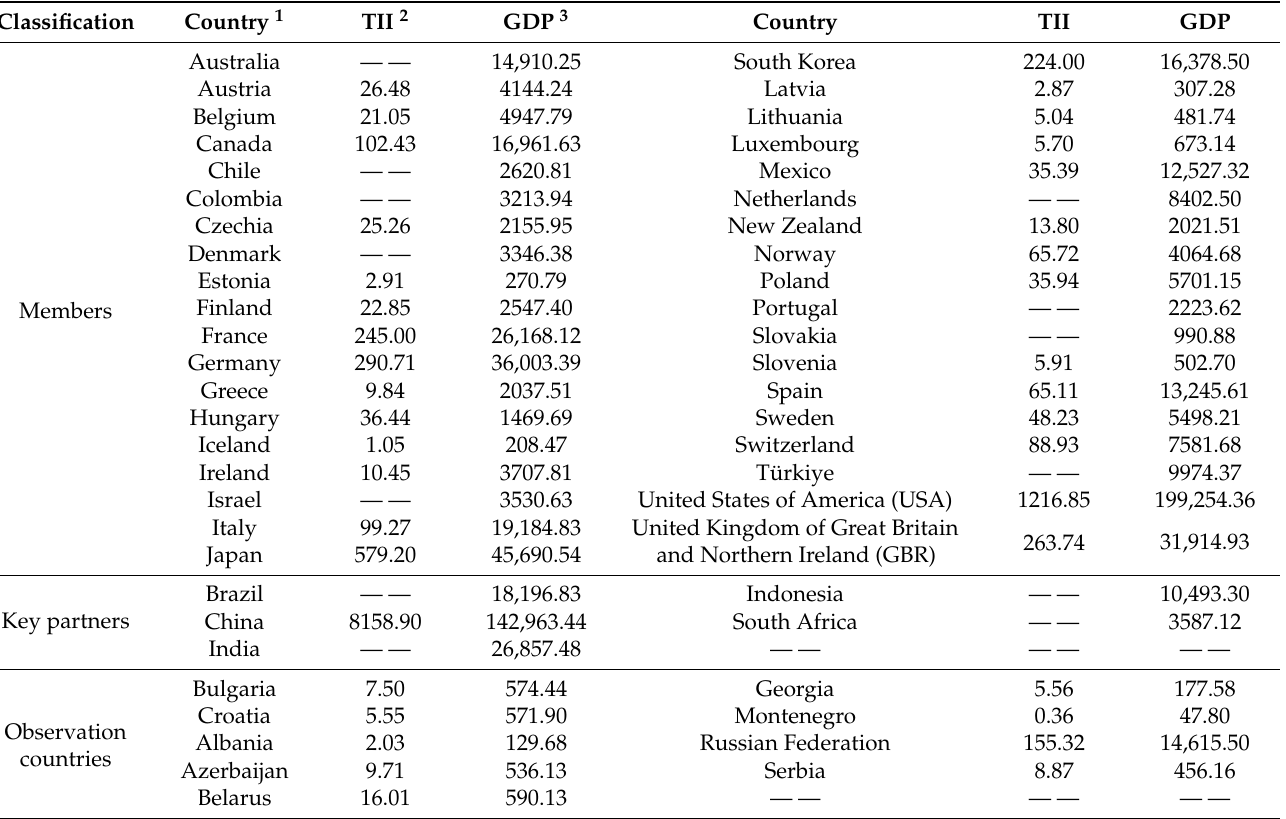
Table 1. TII and GDP of OECD+ countries in 2019 (unit: 100 million